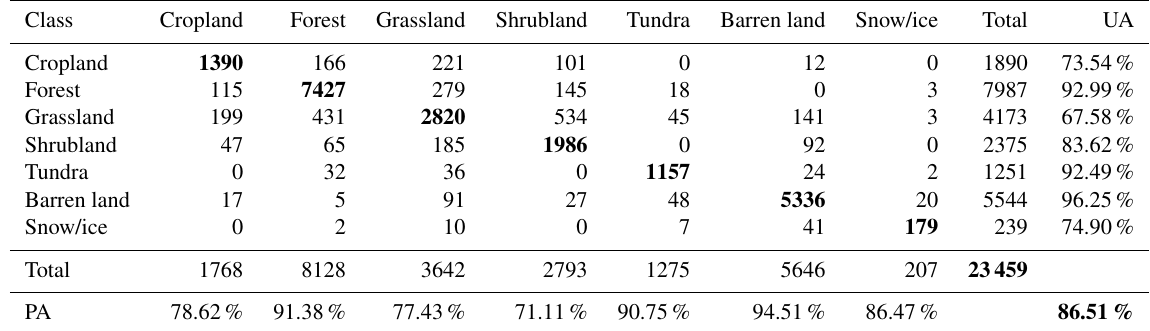
Table 3. Classification accuracy of GLASS-GLC (annual dynamics of global land cover) in 2015 based on FROM-GLC_v2 (Finer Resolution Observation and Monitoring of Global Land Cover product version 2) test samples (overall accuracy = 86 . 51%; UA denotes user’s accuracy, and PA denotes producer’s accuracy). Bold numbers represent correctly classified samples.